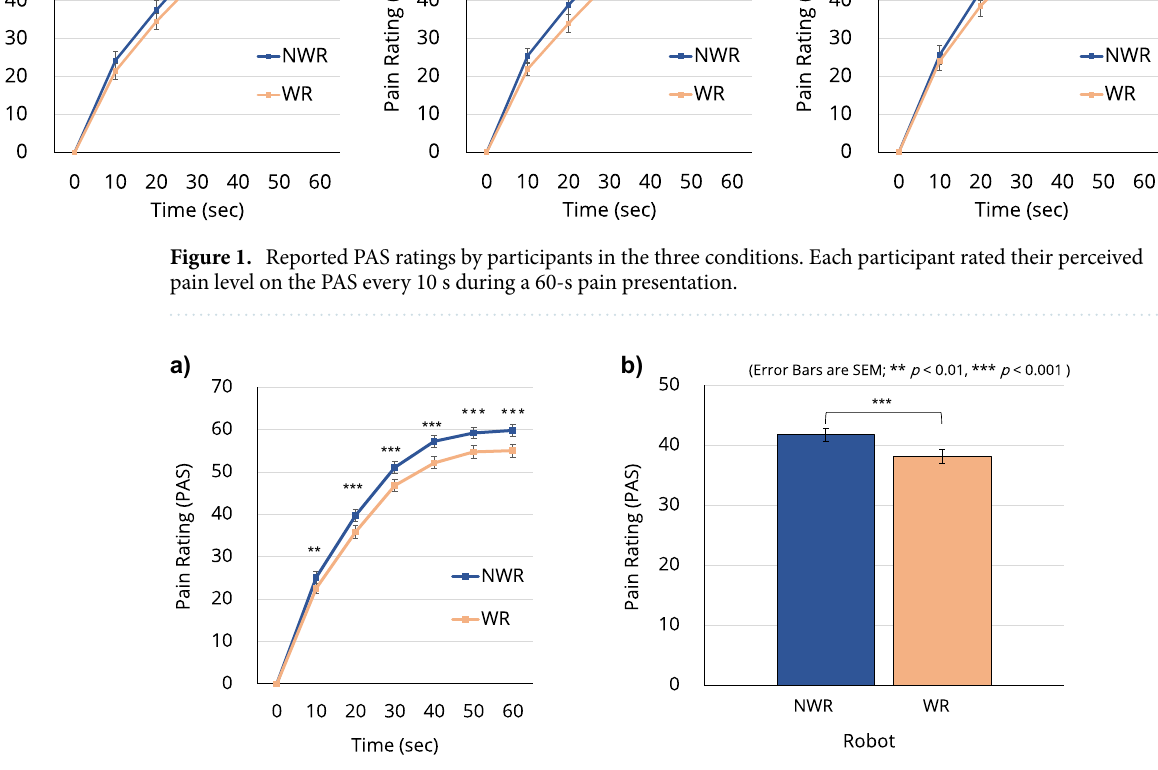
Figure 2. Post hoc comparisons of PAS ratings between NWR and WR. ( a ) Participants reported significantly lower pain ratings when they were WR than when they were NWR ( p < 0.01at10 s and p < 0.001at all the other time points ) . ( b ) A significant main effect of robot (NWR/WR) was also